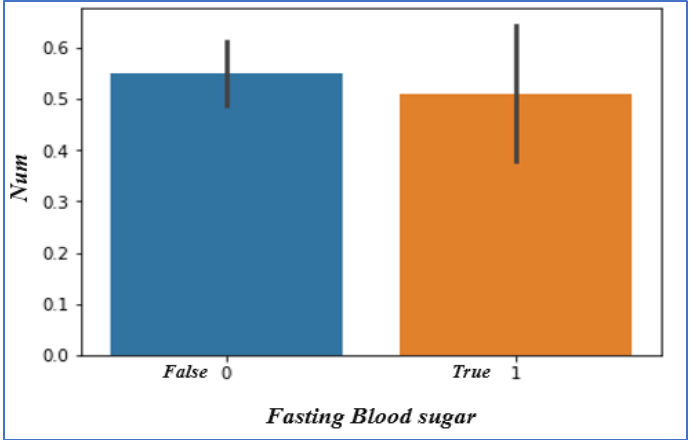
Figure 7. Fasting blood sugar vs. disease chances.